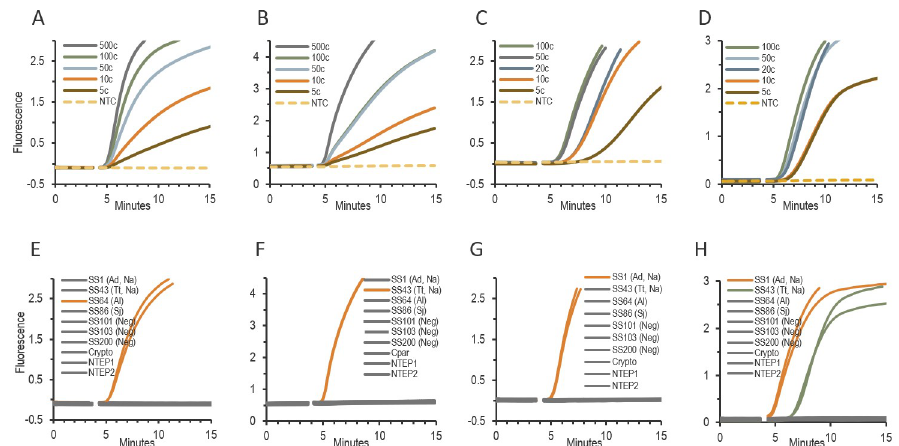
Fig 2. Amplification curves from Al-RPA (A and E), Tt-RPA (B and F), Ad-RPA (C and G) and Na-RPA (D and H). Raw fluorescence intensity of labeled probes used for the detection of plasmids pAl, pTt, pAd and pNa at varying copies per reaction (A, B, C and D), or total DNA extracted from STH-positive stool samples (SS) and genomic DNAs from non-target enteric pathogens (E, F, G and H). Al, A . lumbricoides ; Tt, T . trichiura ; Ad, A . duodenale ; Na, N